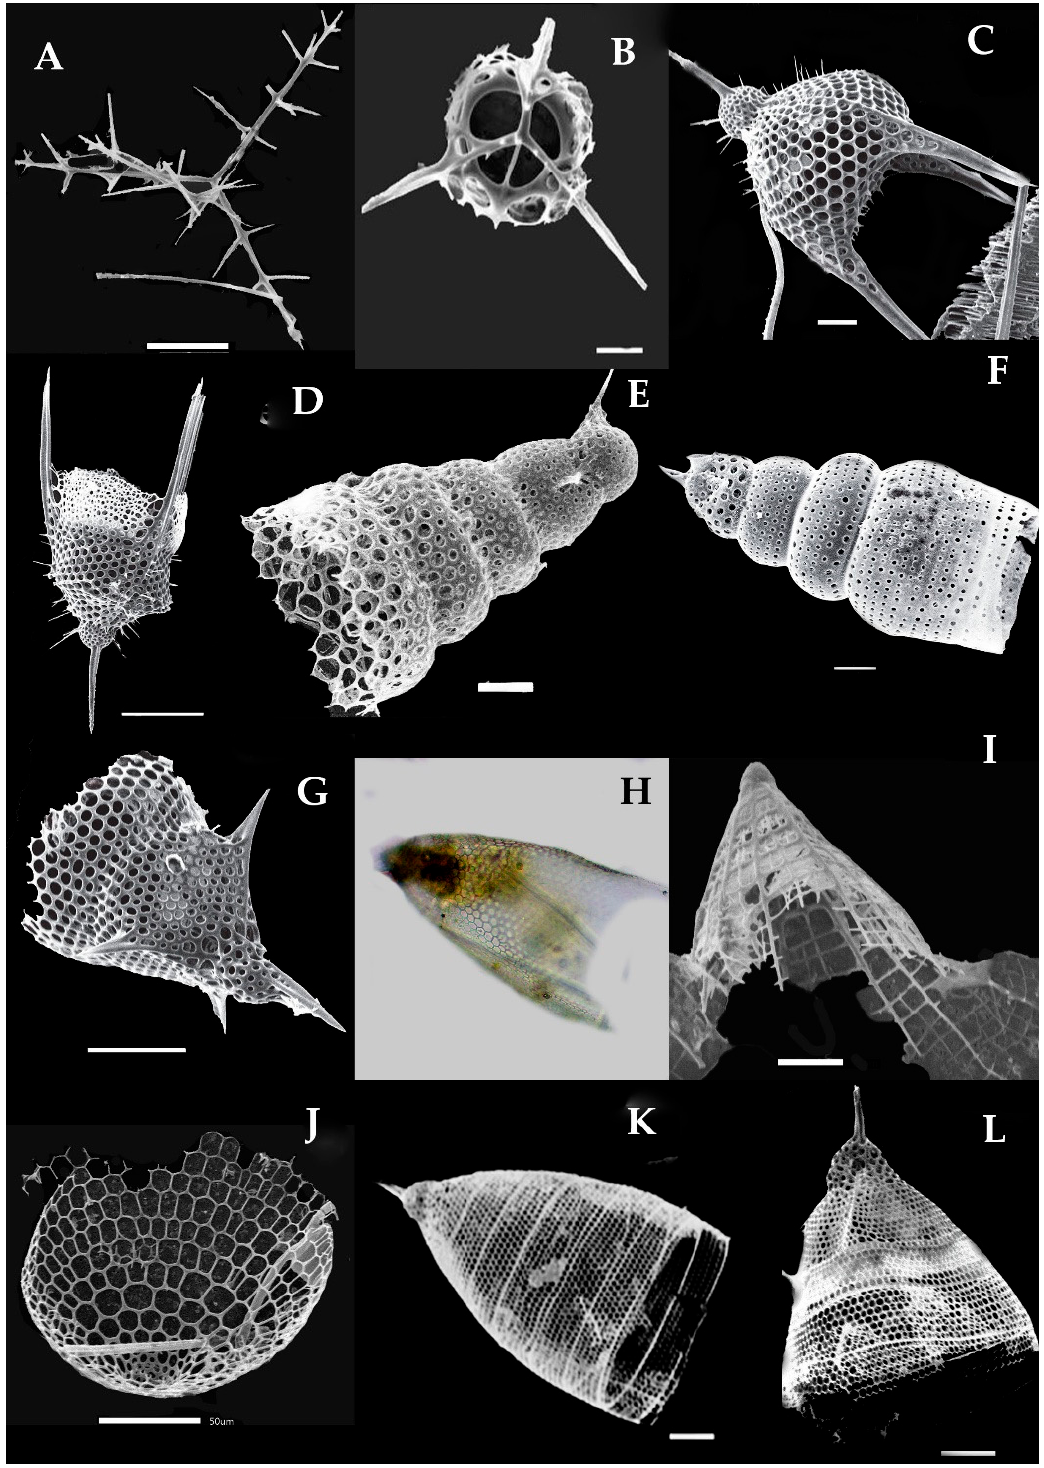
Figure 9. Light and scanning electron micrographs of Nassellarian species ( A – L ). The images were modified from Munir et al. [27]. ( A ) Tetraplecta pinigera ; ( B ) Archibursa tripodiscus; ( C ) Pterocanium praetextum, ( D ) Pterocanium korotnevi; ( E ) Triacartus undulatum , ( F ) Spirocyrtis subscalaris , ( G ) Pterocorys hertwigii ; ( H ) Conarachnium parabolicum; ( I ) Litharachnium tentorium; ( J ) Eucecryphalus clinatus; ( K ) Eucyrtidium dictyopodium; ( L ) Dictyocodon palladius; Scale bar: 10 µm, 20 µm and 50 µm.